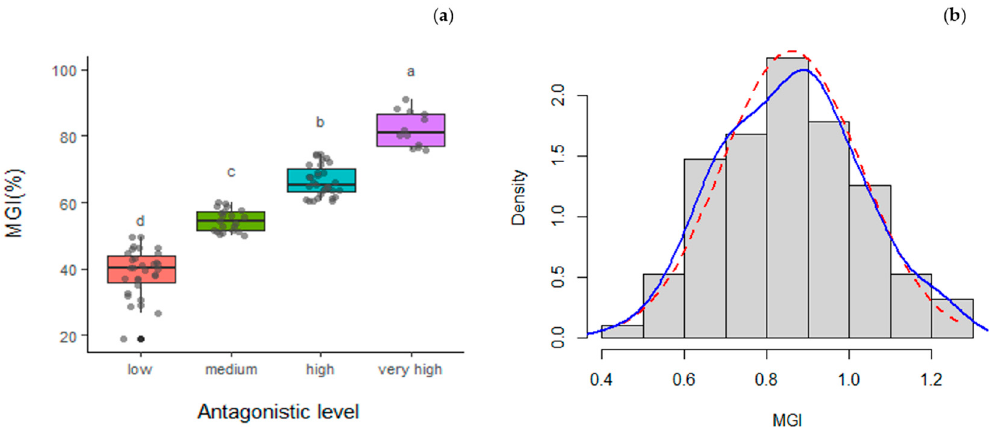
Figure 2. Descriptive analysis of MGI for the 95 Trichoderma spp. isolates tested against P. cinnamomi P90 strain: ( a ) boxplot considering the antagonistic level of the strains against P. cinnamomi following Li et al. [45]; ( b ) histogram with normal curve (dashed red) and density curve (blue) of MGI arcsin-transformed values.